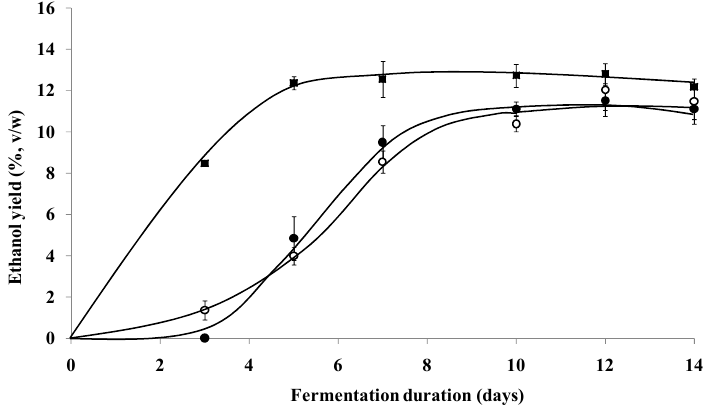
Figure 2. Fermentation efficiency of free yeast cells ( ■ ) and yeast-gellan gum micro-bioreactors in the first ( ● ) and second ( ○ ) fermentation cycles.